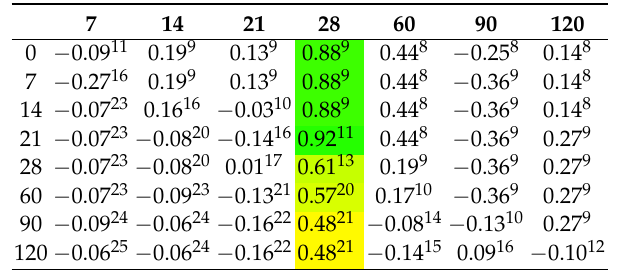
Table 15. Gradient of correlations by interval durations (columns) and leeways (rows) in days.